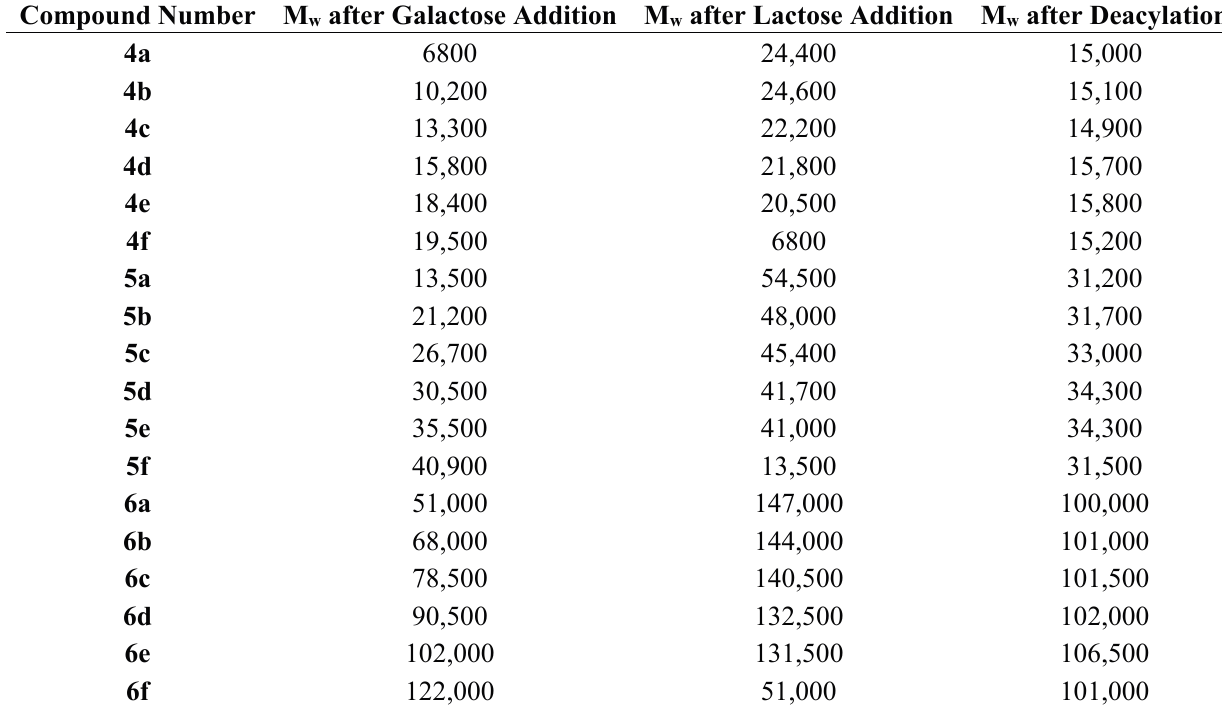
Table 5. MALDI-TOF MS data for heterogeneously functionalized dendrimers 4a – f , 5a – f and 6a – f . Compound